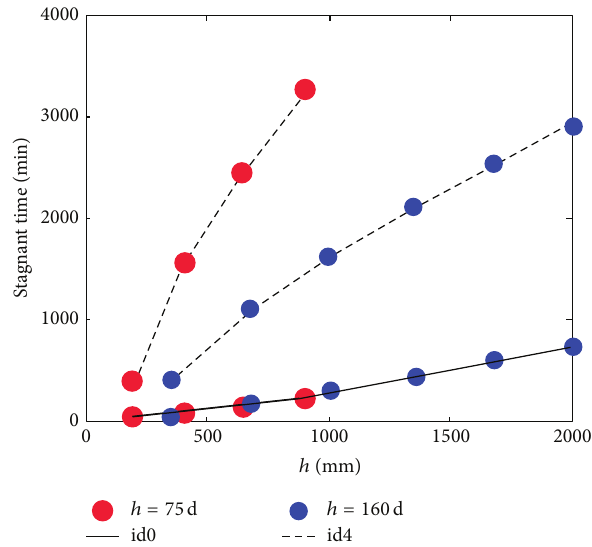
Figure 9: Experiment results of stagnant time of the id0, id4 and the stagnant time ratio id2/id0, id4/id0, of the experiment installation with ℎ = 75 d and ℎ = 160 d.